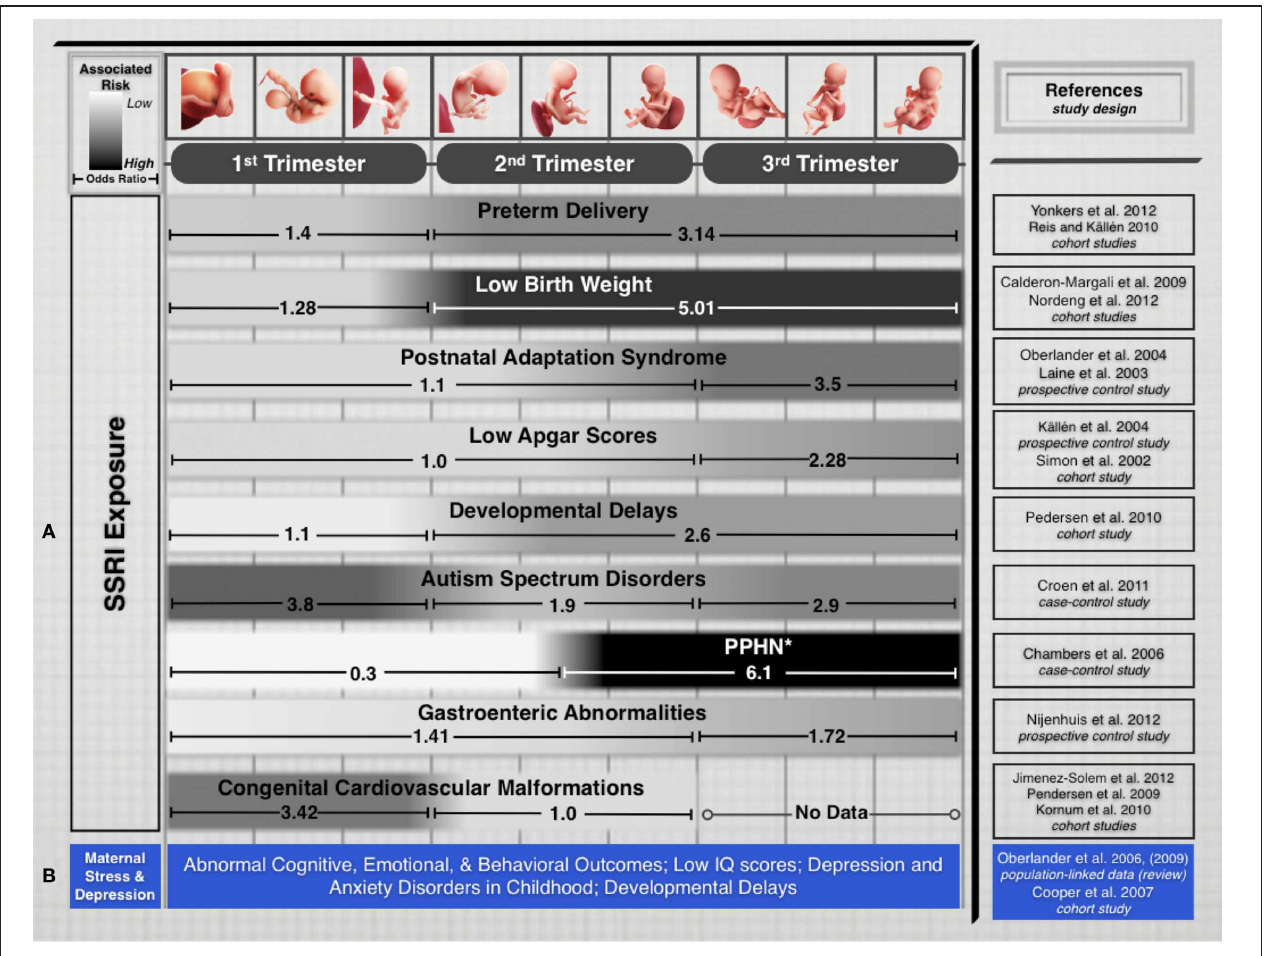
FIGURE 1 | (A) Treatment of maternal depression with SSRIs is associated with varying pregnancy outcomes. While every gestational stage of SSRI exposure has been implicated in increased risks for cognitive, physiological, or developmental teratogenicity, the period of exposure is an important factor that appears to influence clinical outcomes in the offspring. We limited this list to outcomes that have been the focus of several epidemiological studies in recent years and for which differential exposure data during pregnancy was available. (B) Untreated maternal depression and stress have been associated with several risks that affect cognitive and developmental outcomes. While associations are not generally correlated to specific trimesters, exposure